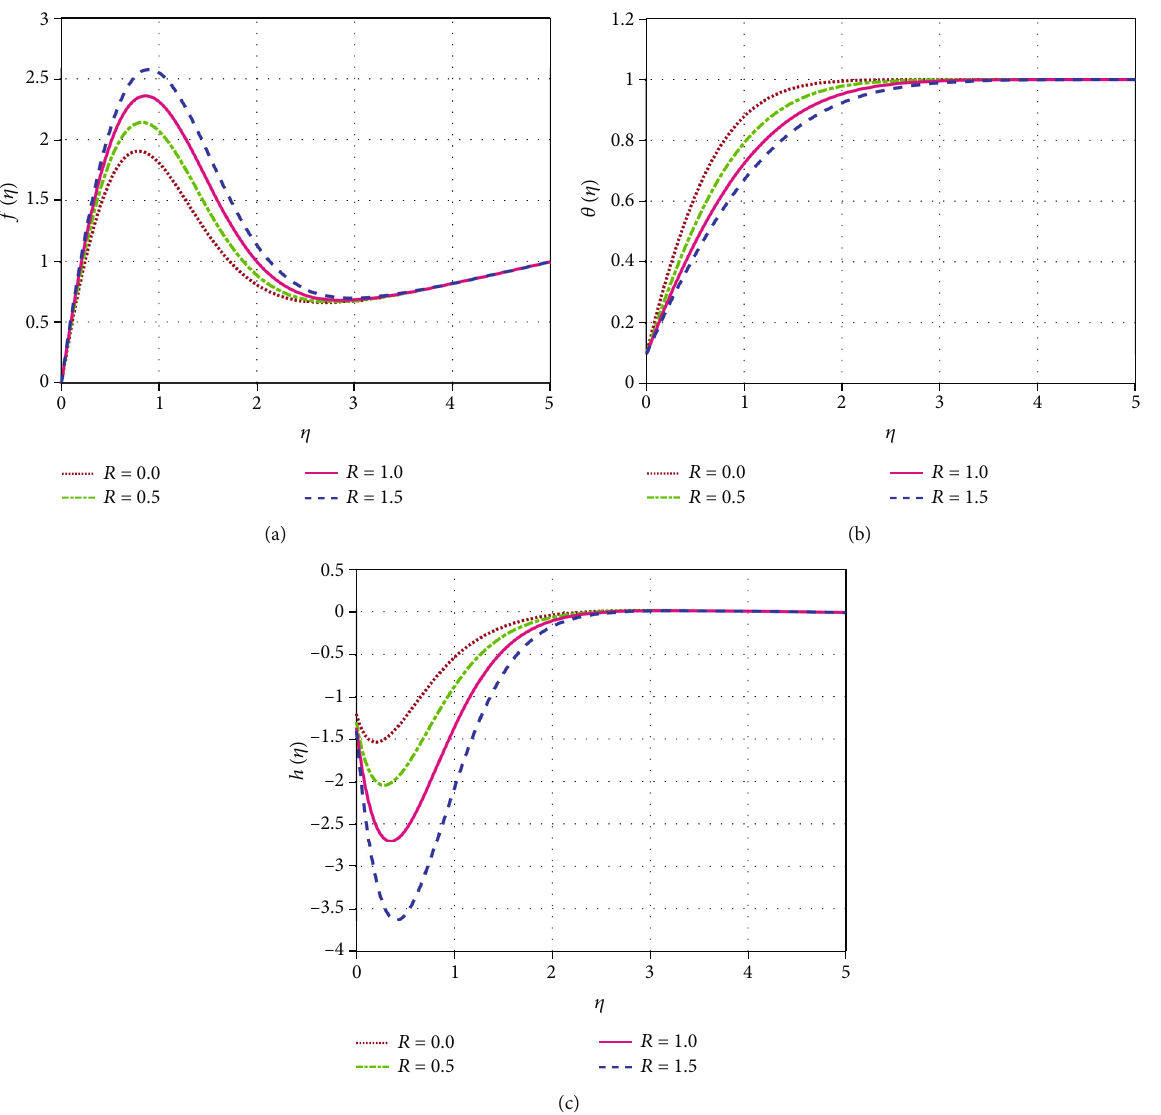
Figure 7: (a) Velocity, (b) concentration, and (c) micro-rotation pro fi les for thermal radiation variation with γ = 45 ° , M =2, c =0.5, =0.33, λ = 1, ξ =3, K =0.5, Gr =10, and Gc Pr =0.71, Sc =0.22, L 1 1